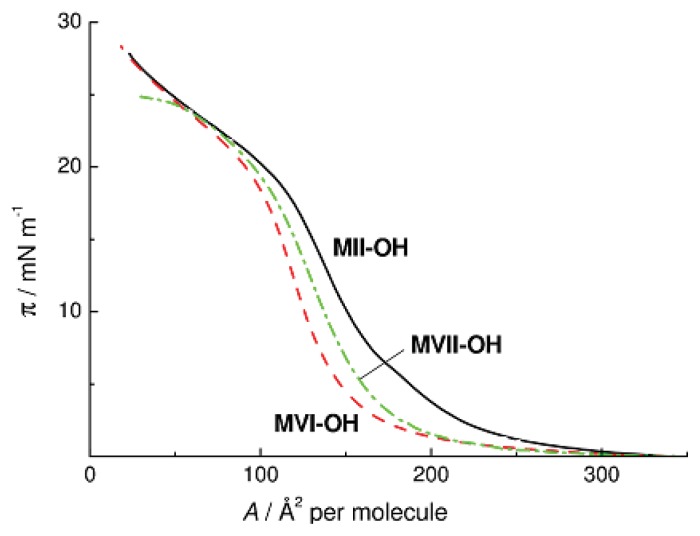
π-A isotherms of MII-OH, MVI-OH, and MVII-OH on water at 20 °C.